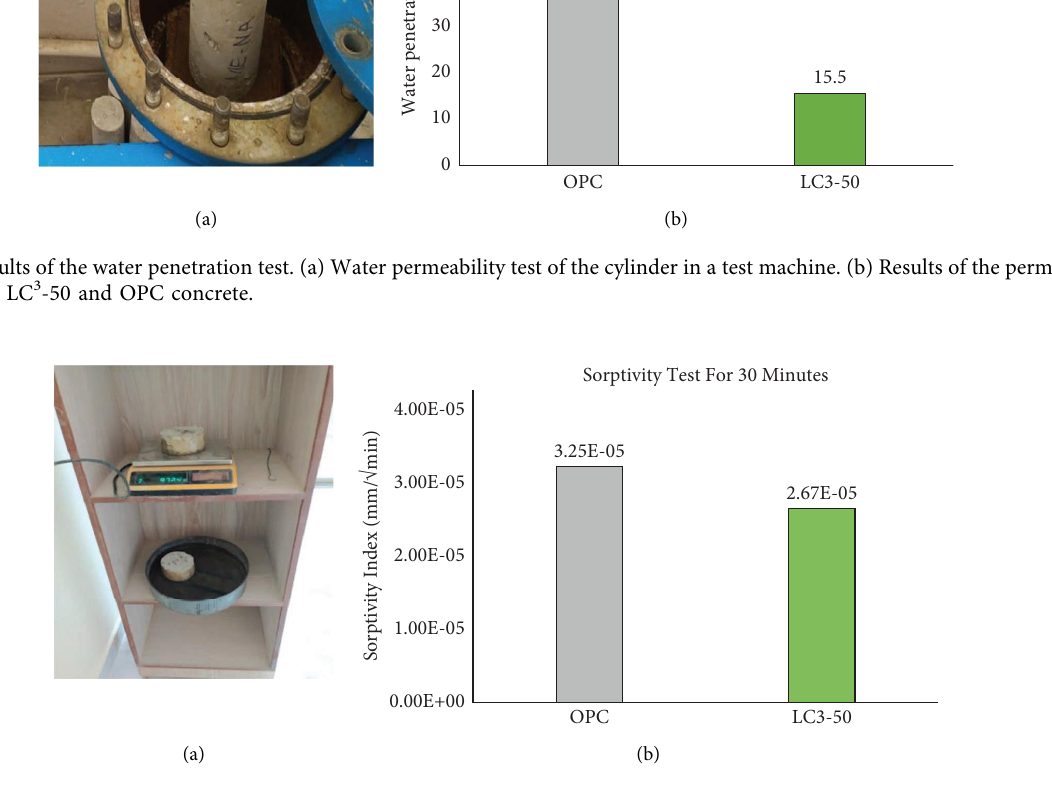
Figure 7: Results of the water penetration test. (a) Water permeability test of the cylinder in a test machine. (b) Results of the permeability test cast from LC 3 -50 and OPC